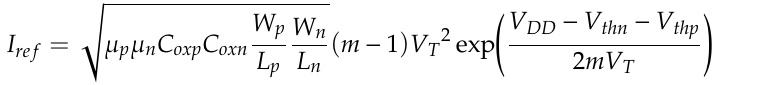
Figure 6. Bias current generator.